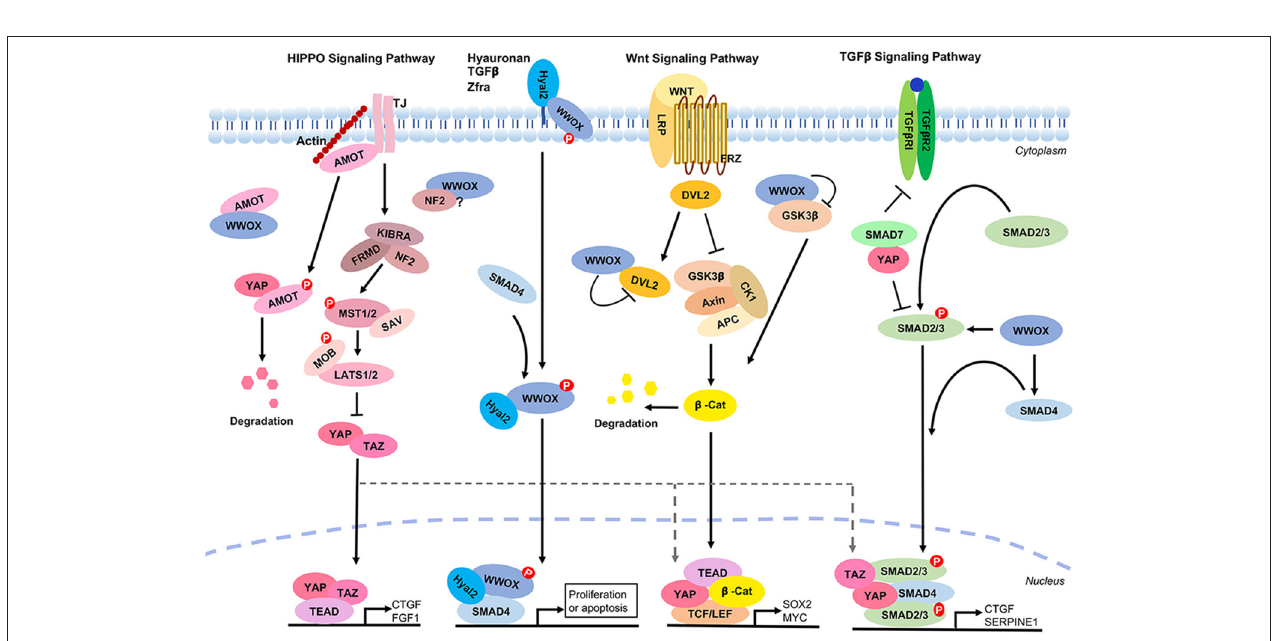
FIGURE 5 | The Hippo signaling in tissue homeostasis, regeneration and cancer. (A) YAP/TAZ activity regulates tissue homeostasis and modulates the cell state. (B) YAP/TAZ activity is declined to a relative low level after birth. The YAP/TAZ activity is reactivated after tissue injuries and constitutively upregulated in cancer.